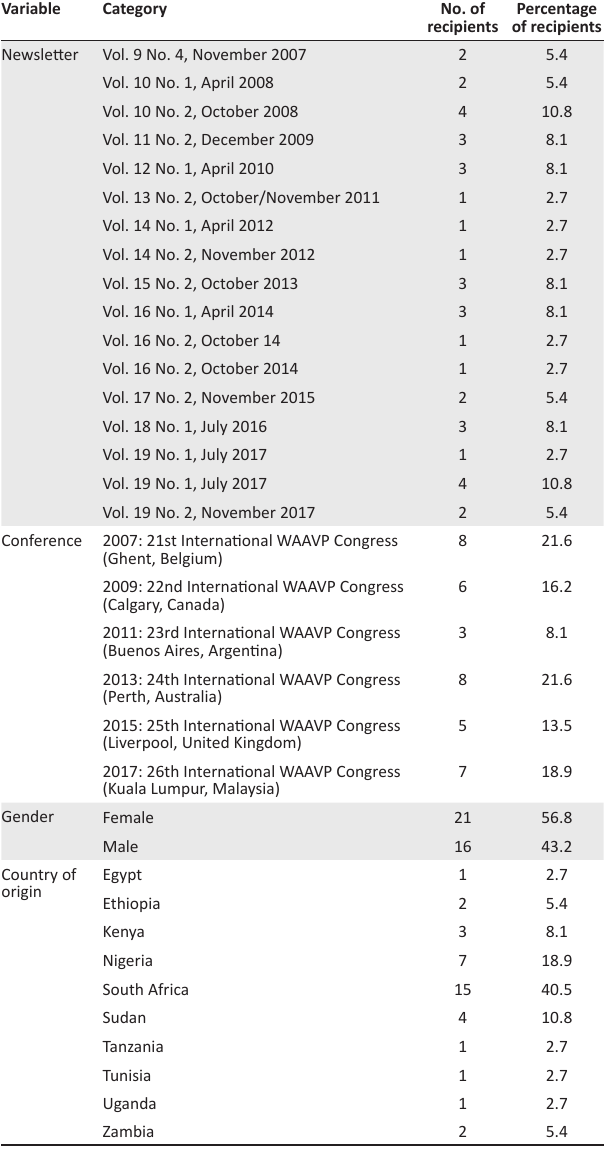
TABLE 1: Baseline data for World Association for the Advancement of Veterinary Parasitology African Foundation scholarship recipients who submitted 37 narratives to the World Association for the Advancement of Veterinary Parasitology Quarterly Online Newsletters for the years 2007–2017.